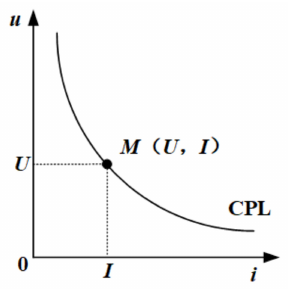
Figure 2. The U - I Characteristic Curve of